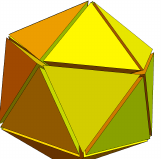
Figure A2. Vertex-sharing 20-tetrahedron cluster uniformly spaced, with gaps between all faces.